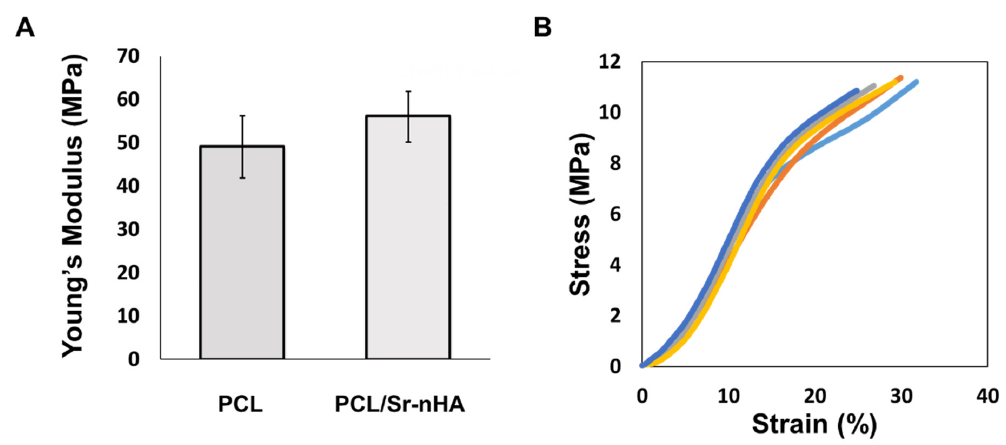
Figure 6. ( A ) Young’s modulus values for PCL and PCL/Sr-nHA multi-layer scaffolds and ( B ) representative stress/strain curves ( n = 5) for PCL/Sr-nHA multi-layered scaffolds tested in